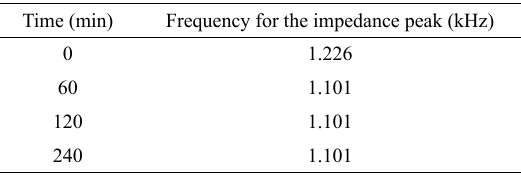
Table 2. Frequency peak values obtained from the 1Hz to 2kHZ frequency scanning.